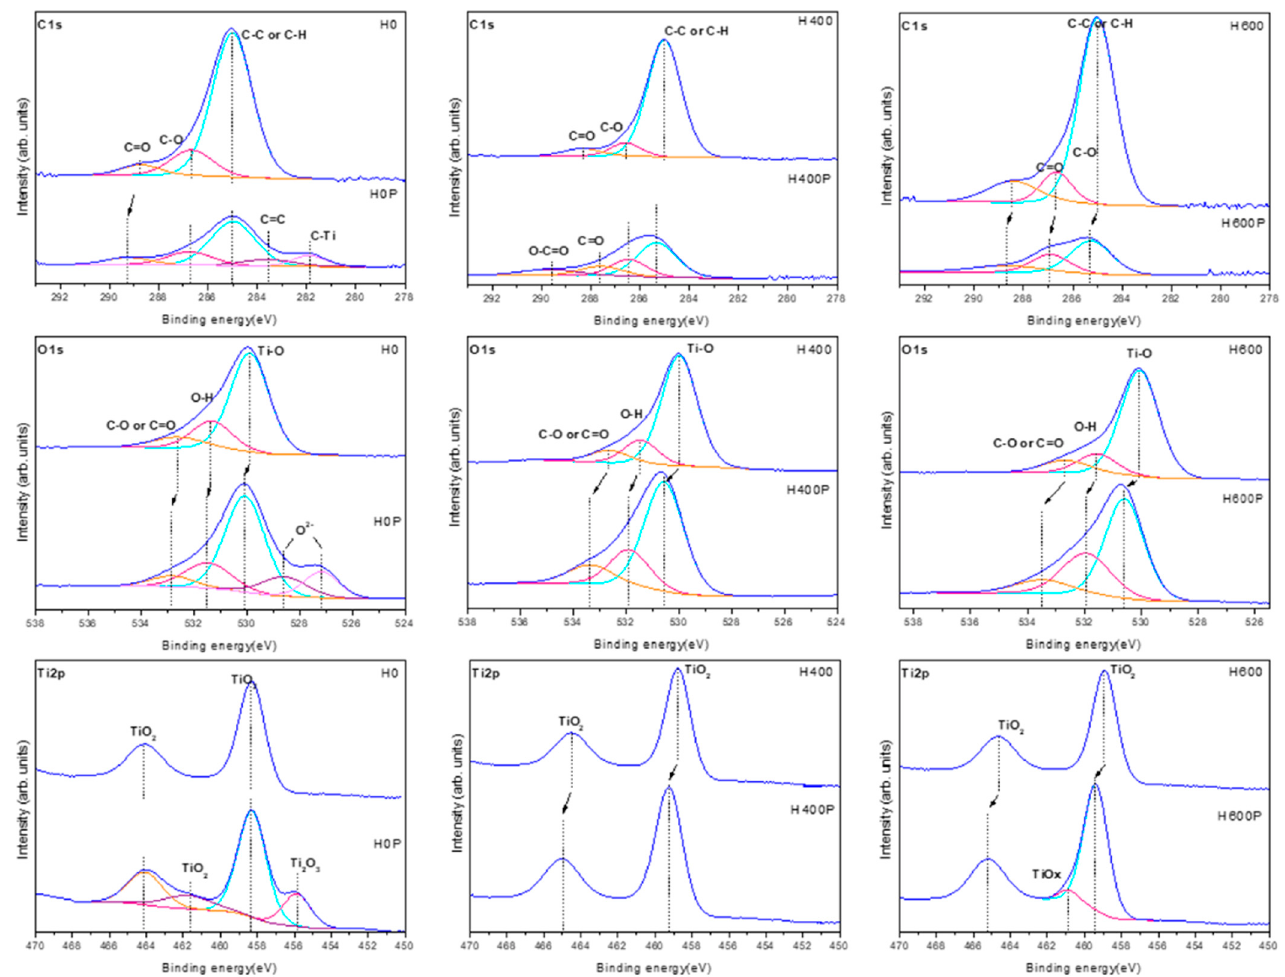
Figure 4. XPS high-resolution spectra of C1s, O1s and Ti2p on samples.